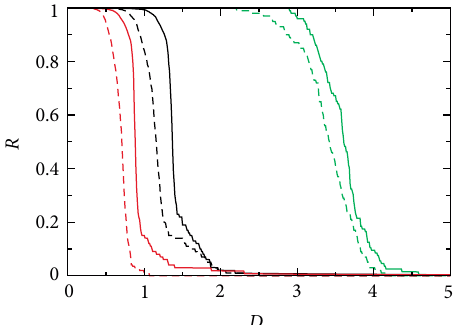
Figure 6 : 𝐷 as the function of average degree of internal links ⟨𝑘 in ⟩ 𝑐 obtained from Figure 5 for different weight distributions: uniform (black), exponential (red), truncated normal with 𝜎 = 0 (magenta), 𝜎 = 1 (green), and 𝜎 = 3